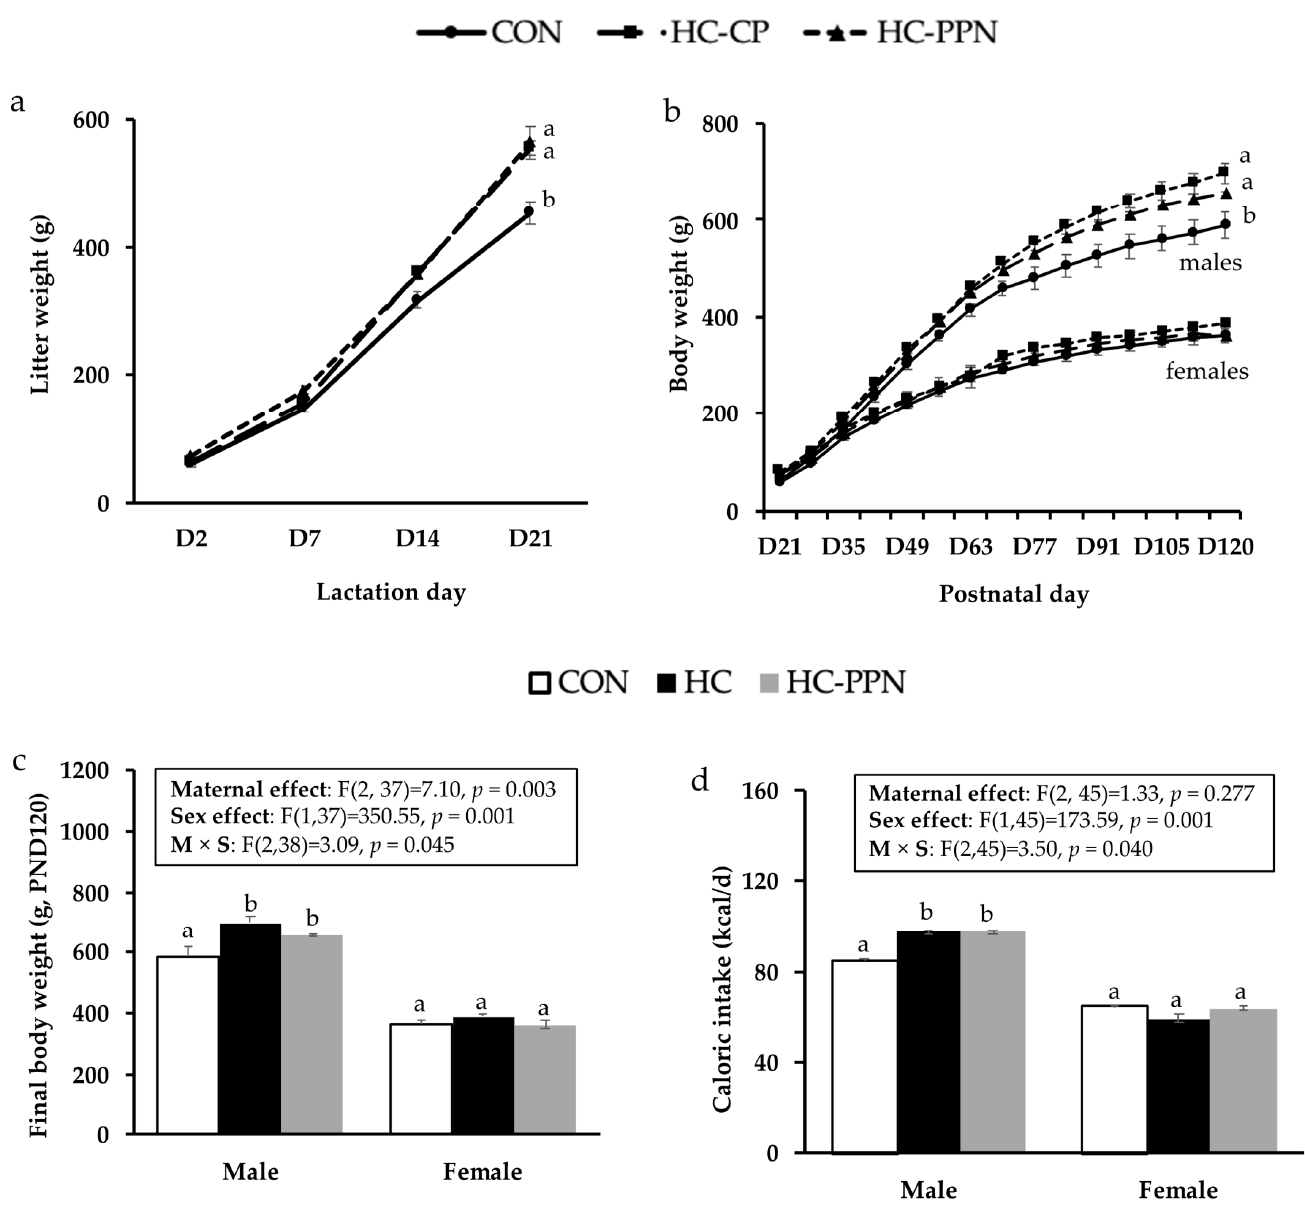
Figure 3. Offspring growth and feed intake. ( a ) Litter growth (g) throughout the lactation period; ( b ) postnatal male and female offspring growth trajectory (g); ( c ) final body weights (g) in male and female offspring; and ( d ) average postnatal caloric intake (kcal/d) in male and female offspring. CON, low-calorie control diet; HC-CP, high-calorie obese-inducing diet with casein protein; and HC-PPN, HC high-calorie diet with supplemental yellow pea protein (25%). Maternal (M), sex (S), and interaction (M × S) were analyzed using two-way ANOVA with LSD post hoc test ( p < 0.05). ab Treatment groups within sex that do not share a superscript are significantly different ( p < 0.05). Data are means ± SE, and n = 7–9 mothers per group.